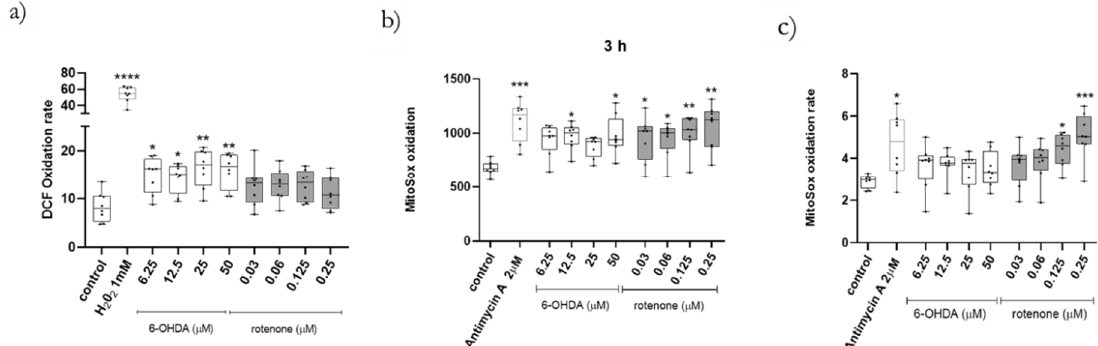
Figure 7. Treatments with both compounds induced an increase in cellular and mitochondrial-derived oxidative stress The fluorogenic substrates DCF ( a ) and Mitosox ( b , c ) were used to study, respectively, cellular and mitochondrial-derived oxidative stress in cells treated with different concentrations of 6-OHDA and rotenone. Cells were either incubated acutely ( a , c ) or for 3 h ( b ) with different concentrations of either compound. Antimycin A, 2 µM, was used as positive control. Data are represented in boxplots in which each dot represents an independent cell population ( n = 8). Kruskal–Wallis test (one-way ANOVA on ranks) pairwise (control vs. 6-OHDA or control vs. rotenone) was used to assess statistical significance, (*) p < 0.05, (**) p < 0.01, (***) p < 0.001 and (****) p < 0.0001.